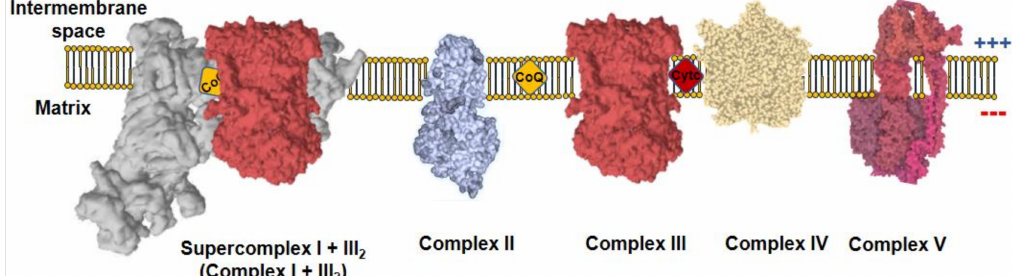
Figure 1. Mitochondrial oxidative phosphorylation system (OXPHOS). The inner mitochondrial membrane (IMM) comprises five protein complexes, which couple the transfer of electrons to H + pumping. Charge distribution across the IMM produces a ∆Ψ m , negative inside. Complex I (CI) is normally found inside supercomplexes with complex III (CIII) (supercomplex I + III 2 ) or CIII+complex IV (CIV) (N-respirasome), a particularly relevant feature for mitochondrial reactive oxygen species (ROS)